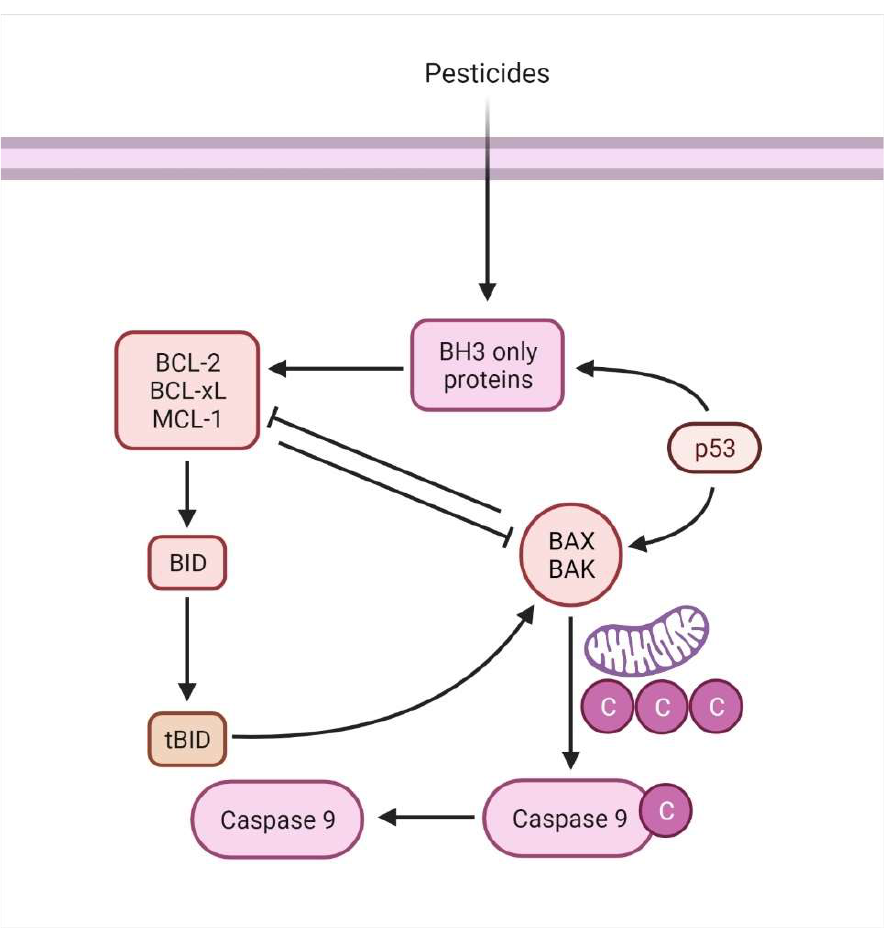
Figure 5. The mitochondrial mediated/intrinsic apoptosis is associated with the activation of BH3 proteins. BH3